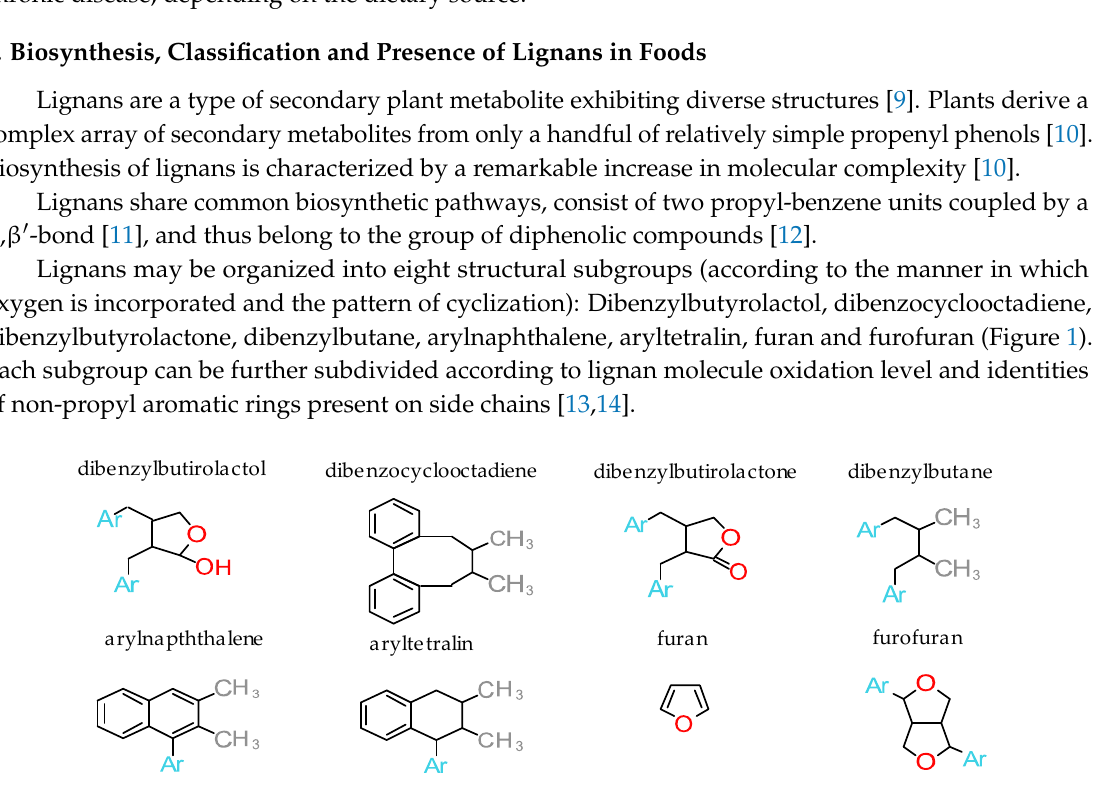
Figure 1. Structural subgroups of lignans ( Ar=Aryl ).